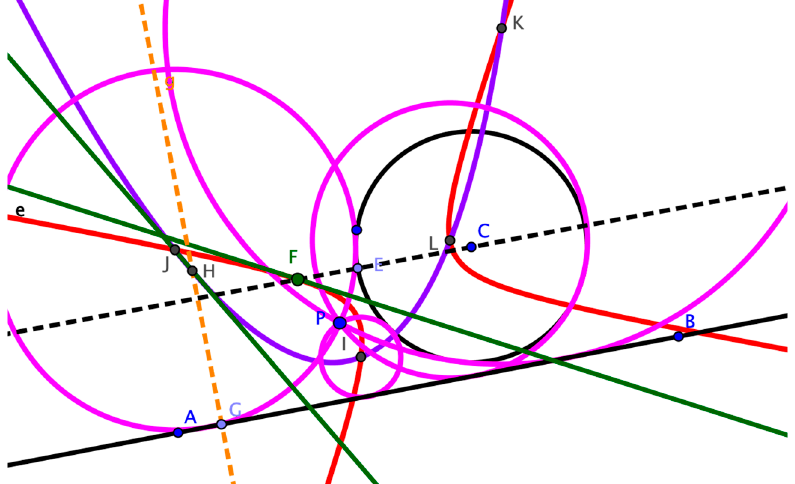
Figure 10. Drawing four tangent circles that solve the problem (https://www.geogebra.org/m/xkf9g6xs, accessed on 2 January 2021). Comment: The consideration of the limit case (zero and infinity radii of circles) led